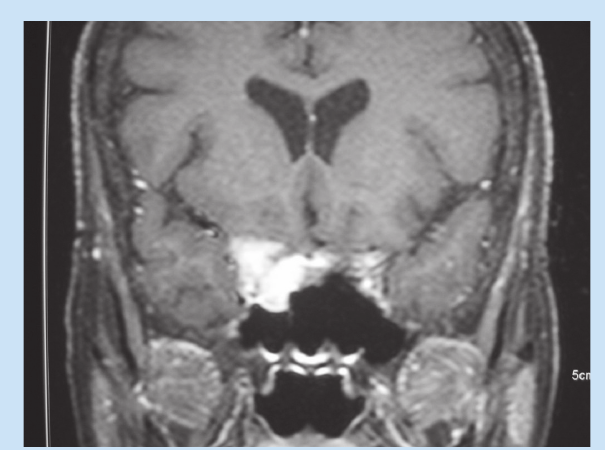
Fig. 4. Enhancing right parasellar/paracavernous mass on coronal post- gadolinium imaging.